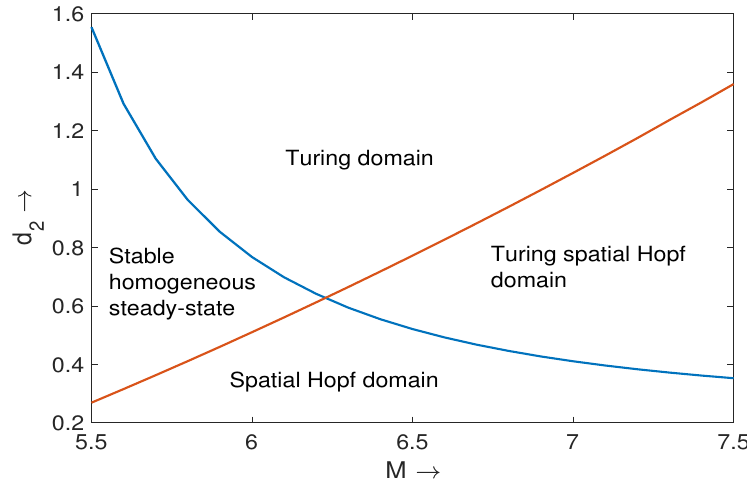
Figure 1. Turing and Hopf stability boundaries in the ( M , d 2 )-parameter